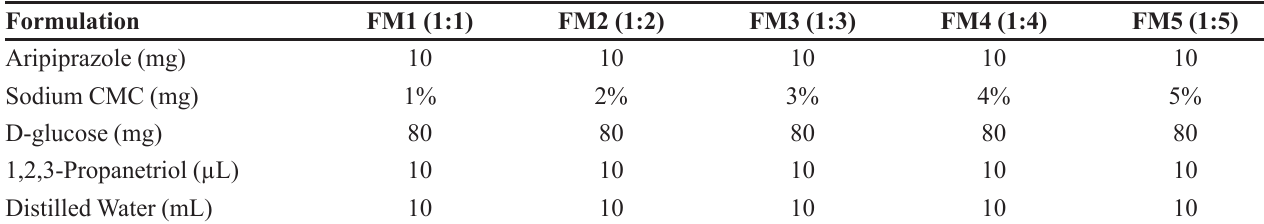
TABLE II - Formulation table of optimized aripiprazole loaded flexy films of sodium CMC as Film former